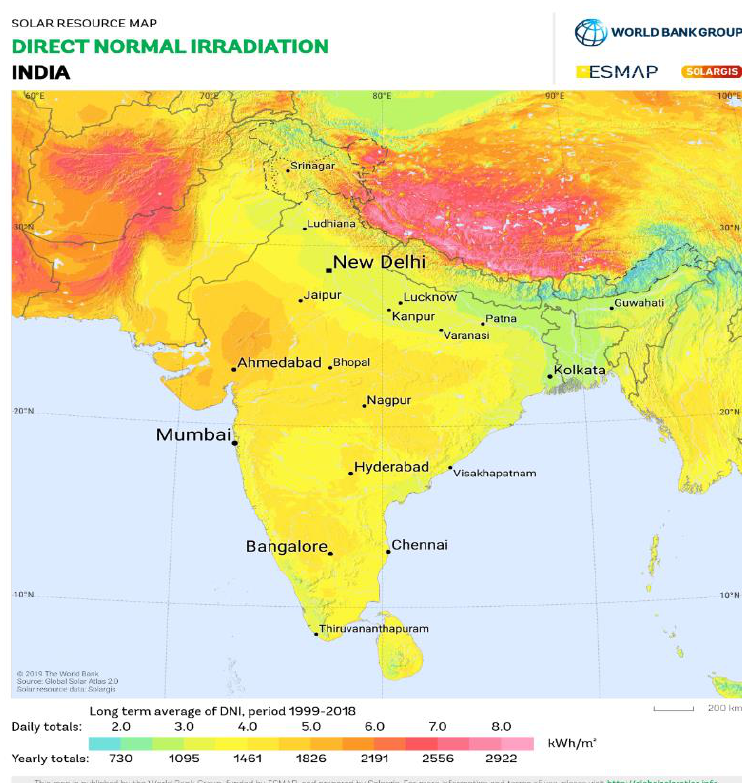
Figure 3. DNI map of India [57].